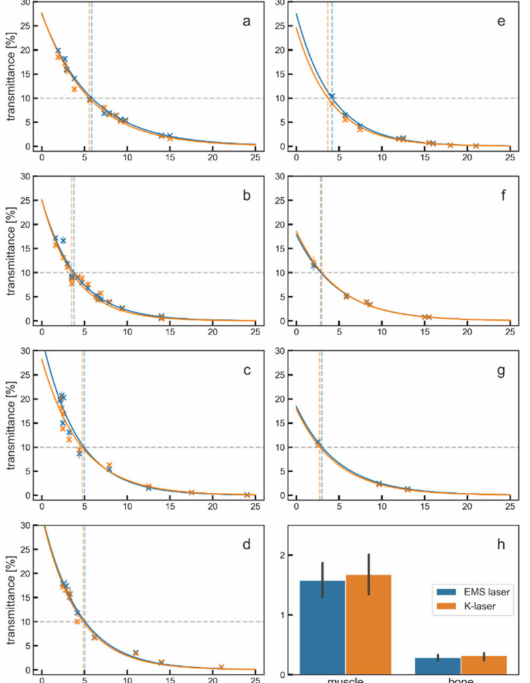
Figure 4. Results of penetration depth measurements for different tissues (( a ), chicken muscle; ( b ), porcine muscle; ( c ), beef muscle 1; ( d ), beef muscle 2; ( e ), porcine skin; ( f ), beef fat; ( g ), beef tendon; ( h ), porcine muscle and bone). Transmittance in percent is plotted against the tissue thickness in millimeters for the EMS laser (blue dots and blue lines) and the K-laser (orange dots and orange lines) ( a – g ). In addition, bone tissue and muscle tissue were compared for a fixed thickness of 15 mm ( h ). Measurements were performed with muscle tissue specimens ( a – d ) and with non-muscular tissue specimens ( e – g ) from different animal species. Each point represents the average of seven measurements; the according standard deviations are indicated by vertical lines. Solid lines represent best fitting transmittance curves. The 10% penetration depth is illustrated by dashed vertical lines in the color of the according laser therapy